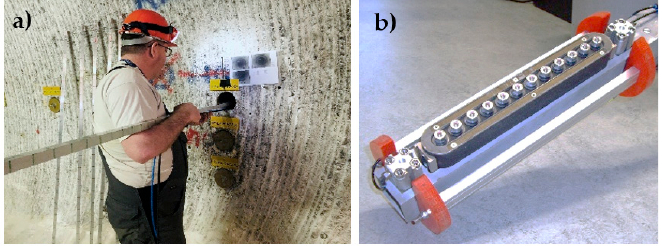
Figure 2. ( a ) Borehole probe measurement at sealing structure, ( b ) Prototype borehole probe.